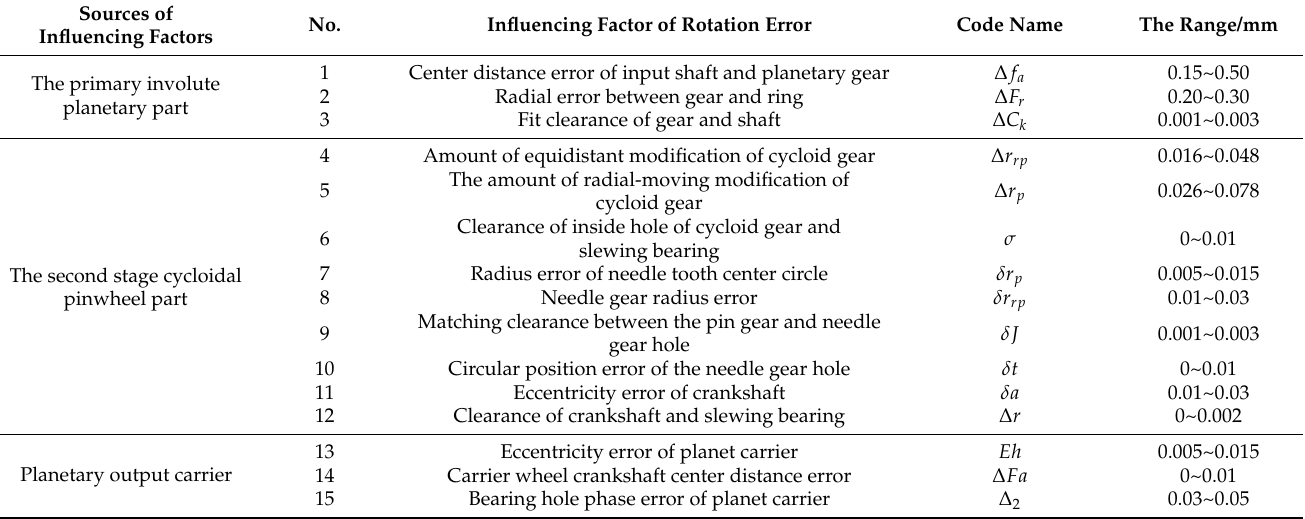
Table 2. RV reducer rotation error static influence factors and parameters to take the value